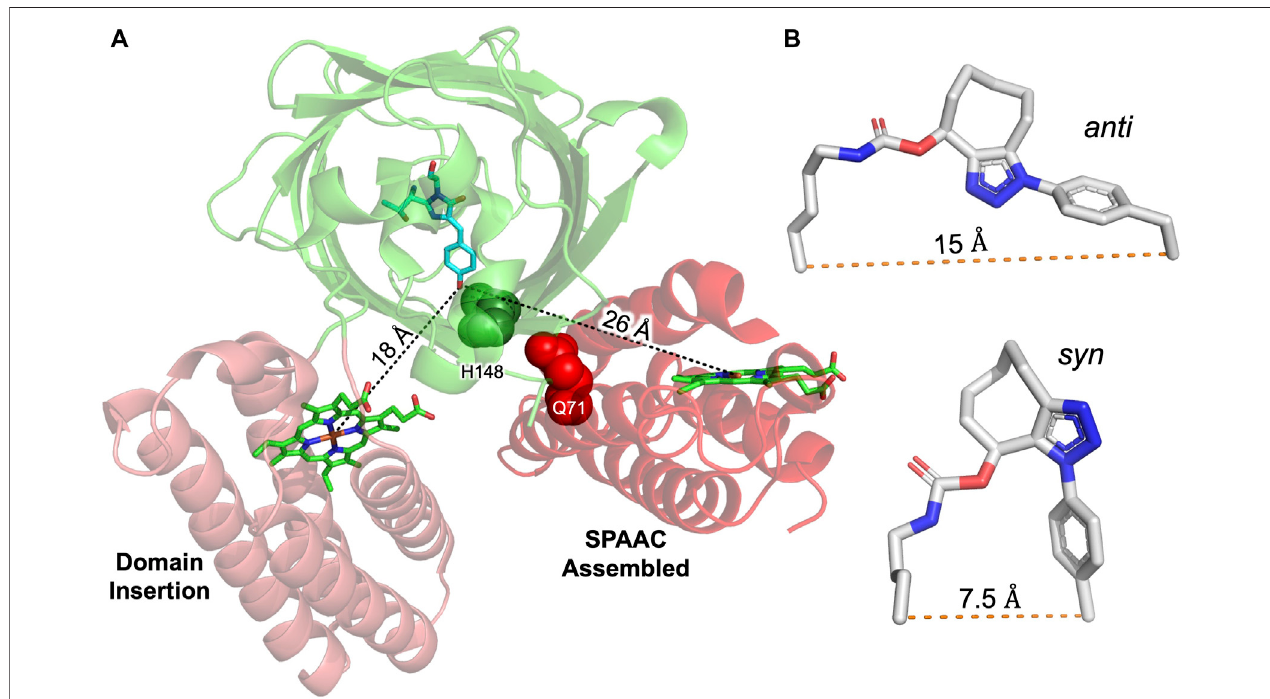
FIGURE5| ComparisonofchromophoredistancesbetweenGFPandcyt b 562 constructedbydomaininsertionorSPAACassembly.Alignmentofcrystalstructure (3u8p) of EGFP-cyt b 562 CG6 domain insert variant (Arpino et al., 2012) with the highest ranked model of sfGFP (2b3p) and cyt b 562 (1 qpu) obtained by RosettaDock. GFP (green) used as centre of alignment with chromophore shown (cyan sticks). The measured distance between the GFP chromophore phenolic hydroxyl group and centraliron ofeach haem chromophore areshown associated withthe black dotted lines. Residues mutated toncAAsare shown as spheres and labelled. (B) The anti (derived fromPDB 5 nhn(Worthy etal., 2019))and syn (derived fromPDB 5ni3(Popeet al.,2020))con fi gurations aroundthetriazolebondwiththe relative distances between the C α of the two original amino acids